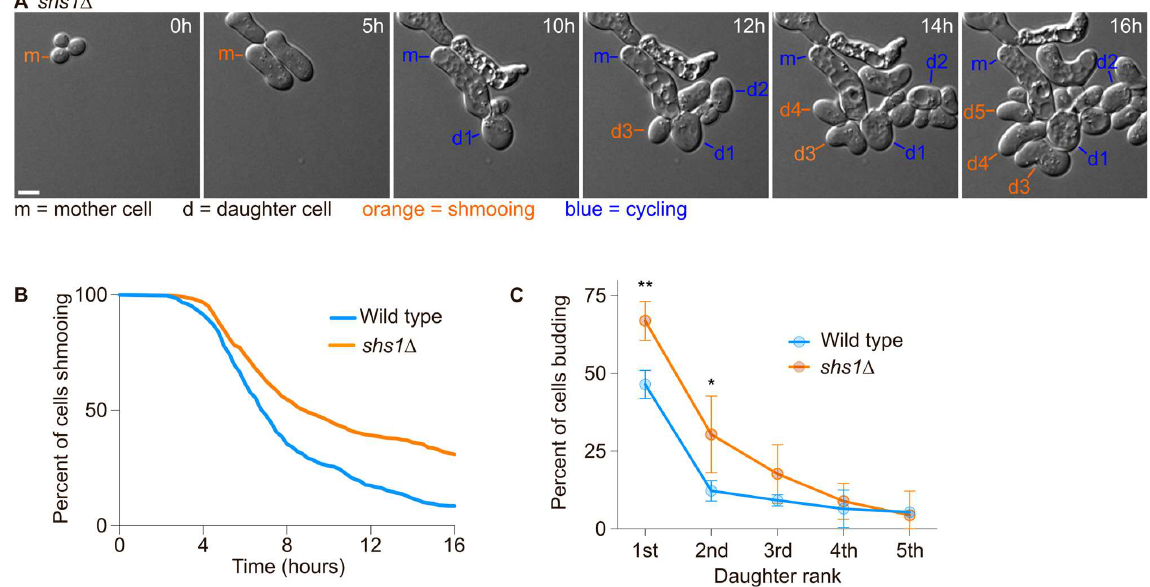
Figure 4. The septin subunit Shs1 is required for an efficient escape and asymmetric inheritance of the pheromone refractory state. ( A ) Escape of a WT cell exposed to 7 nM of pheromone. Here, m = mother cell, d# = daughter cells of the escaped mother cell. Scale bar = 5 µm. ( B ) Percentage of initial cells still shmooing after the indicated time. N > 305 cells. ( C ) Percentage of the daughter cells budding immediately after separation from the mother cell. Mean ± SD are presented from 3 independent experiments. The p -values ** < 0.01, * < 0.05 obtained from a two-way ANOVA. Thus, we conclude that septins are required for the retention of the pheromone refrac- tory state in the mother